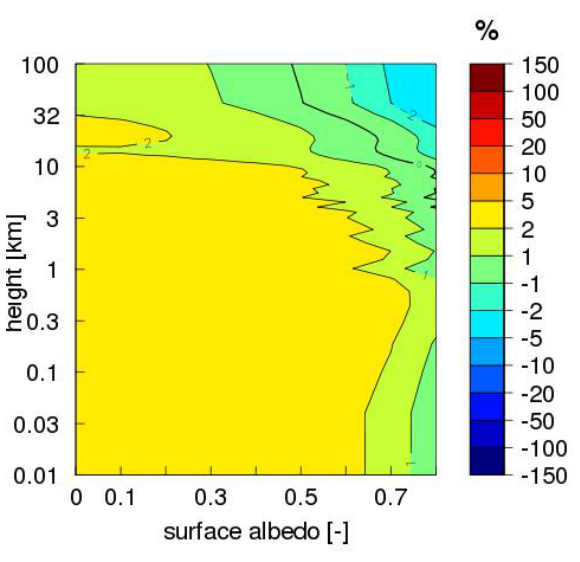
Figure 7. As for Fig. 6 but for hlradia compared to Kato-DISORT.